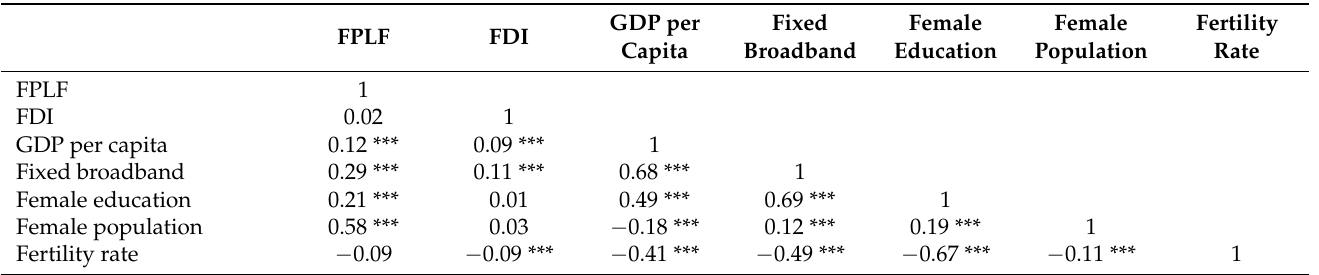
Table 2. Correlations between FPLF and other explanatory